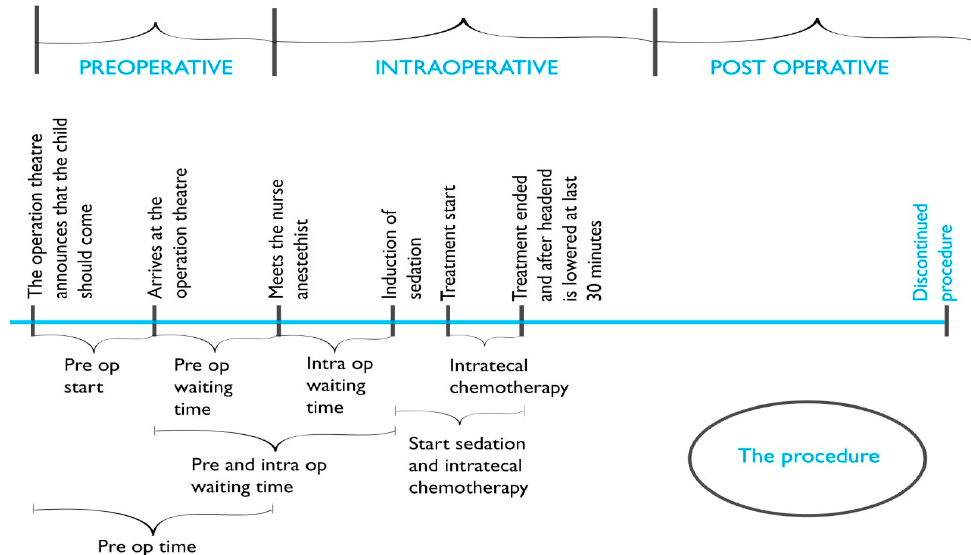
Figure2. Thethreephasesoftheprocedureforintrathecalchemotherapyandtimeintervalsinvestigated. Figure 2. The three phases of the procedure for intrathecal chemotherapy and time intervals investigated.